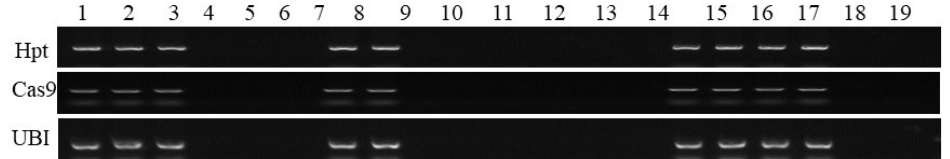
were detected using PCR ampli fi cation (Figure 3; Supplementary Table S1). The vector free plantlets continued to be sequenced to verify the mutation site of Rc gene (Table 1).